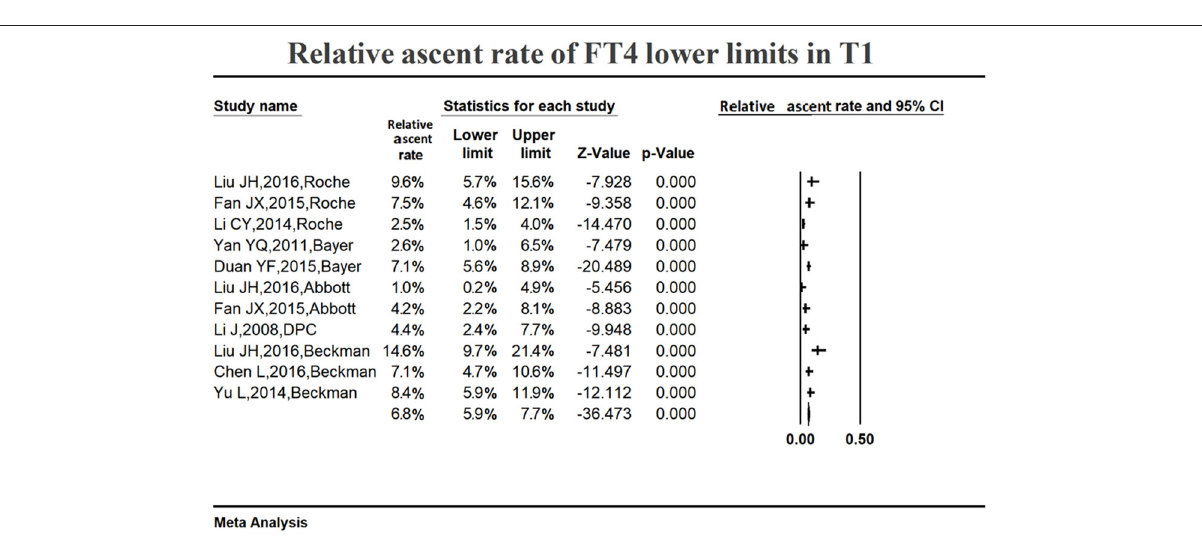
FIGURE 6 | Meta-analysis of relative ascent rate of FT4 lower reference limits in early pregnancy. Figure shows unadjusted relative ascent rate of FT4 lower limit estimates in early pregnancy with 95% confidence limits for each study selected. Pooled relative ascent rate estimates are represented as diamonds in this